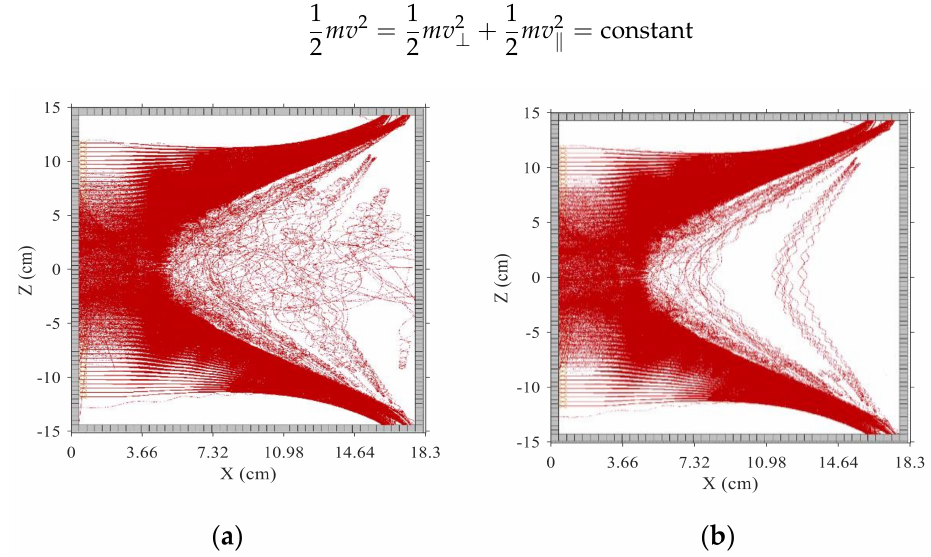
Figure 5. ( a ) The projection of all electrons on the X − Z plane; ( b ) The projection of electrons on the X − Z plane within the range of the Y-axis [ − 4 mm, 4